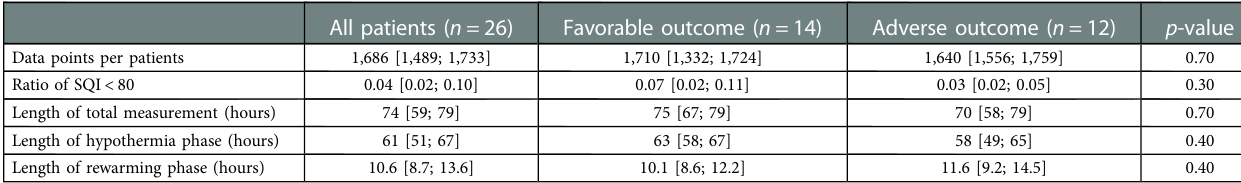
TABLE 3 Technical details of ICON